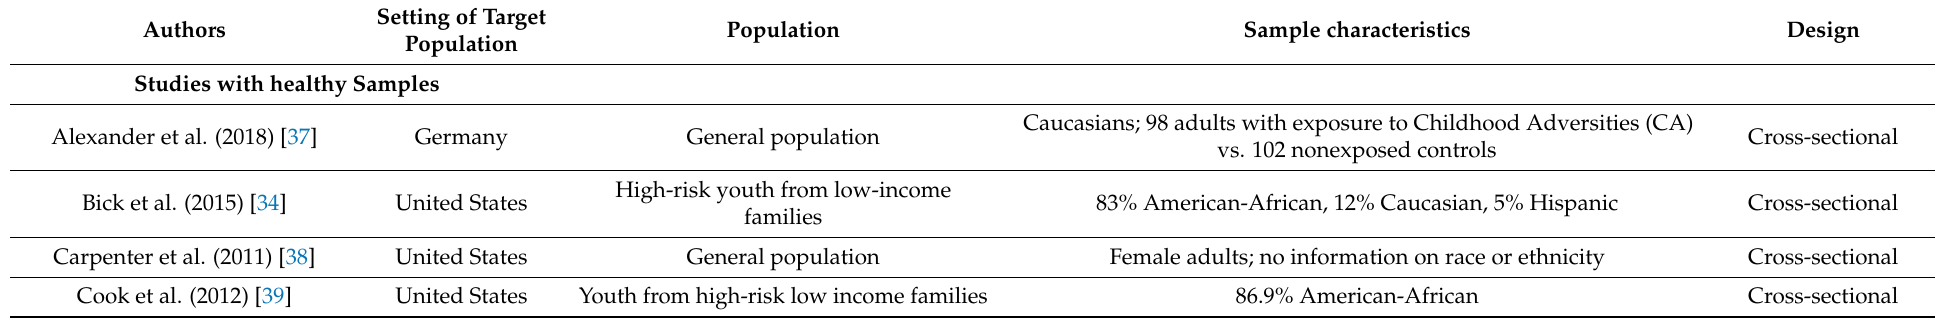
Table 3. Supplementary information for 12 studies included in the